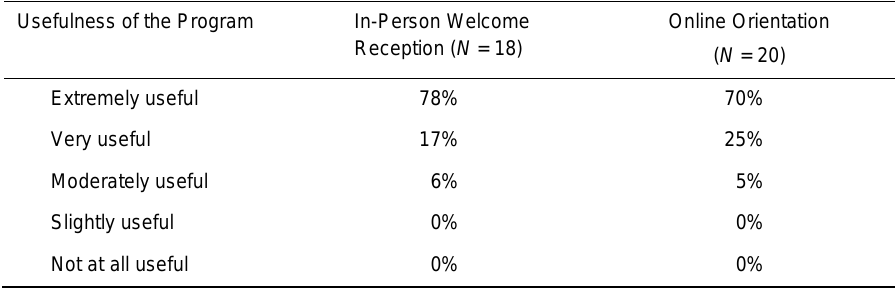
Table 2. On-Boarding Survey